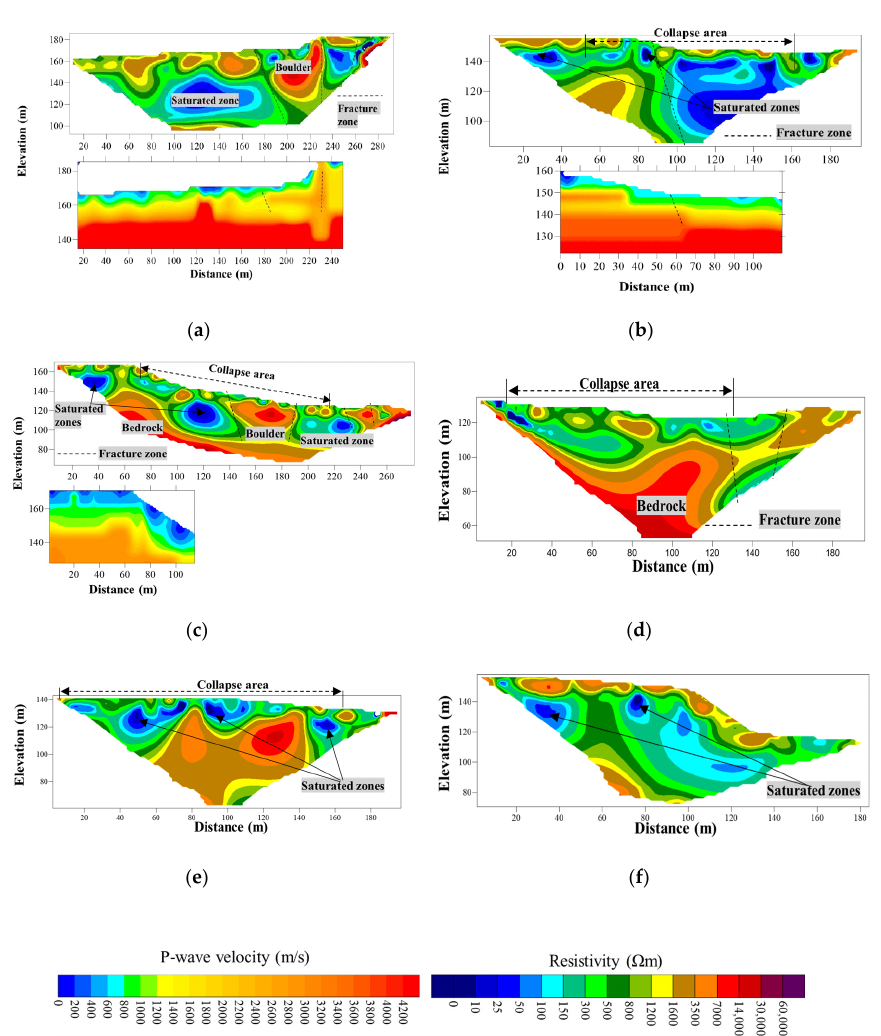
Figure 7. Inversion model of 2-D resistivity and seismic refraction: ( a ) HR1 and HS1; ( b ) HR2 and HS2; ( c ) HR4 and HS3; ( d ) HR3; ( e ) HR5; s( f )